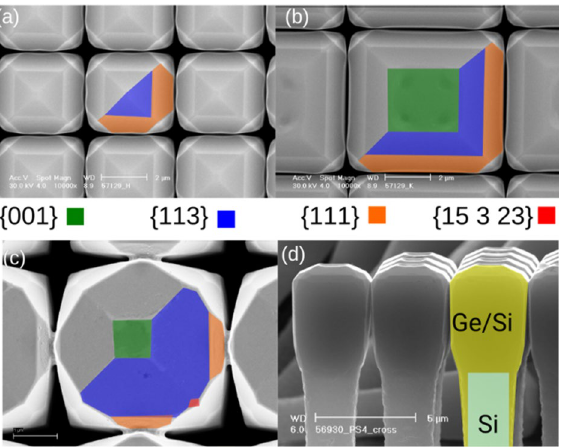
Figure 1. SEM-images of the growth experiments. A top view for Si microcrystals on top of ( a ) 1 × 1 μm Si pillars and ( b ) of 4 × 4 μm Si pillars, both spaced by 3 μm. ( c ) A top view for a Ge microcrystal. Facets